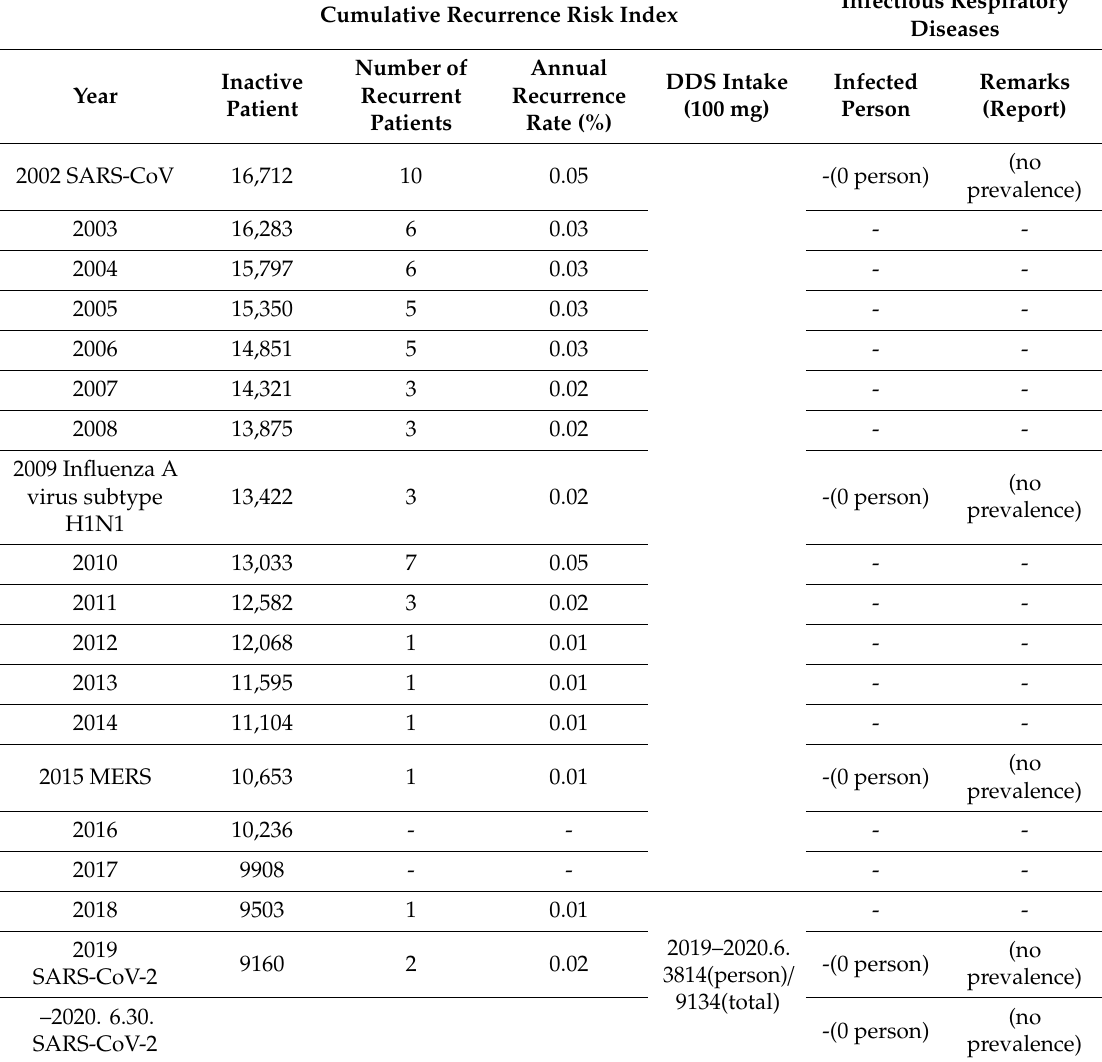
Table 2. Hansen’s disease recurrences and prevalence of respiratory infectious